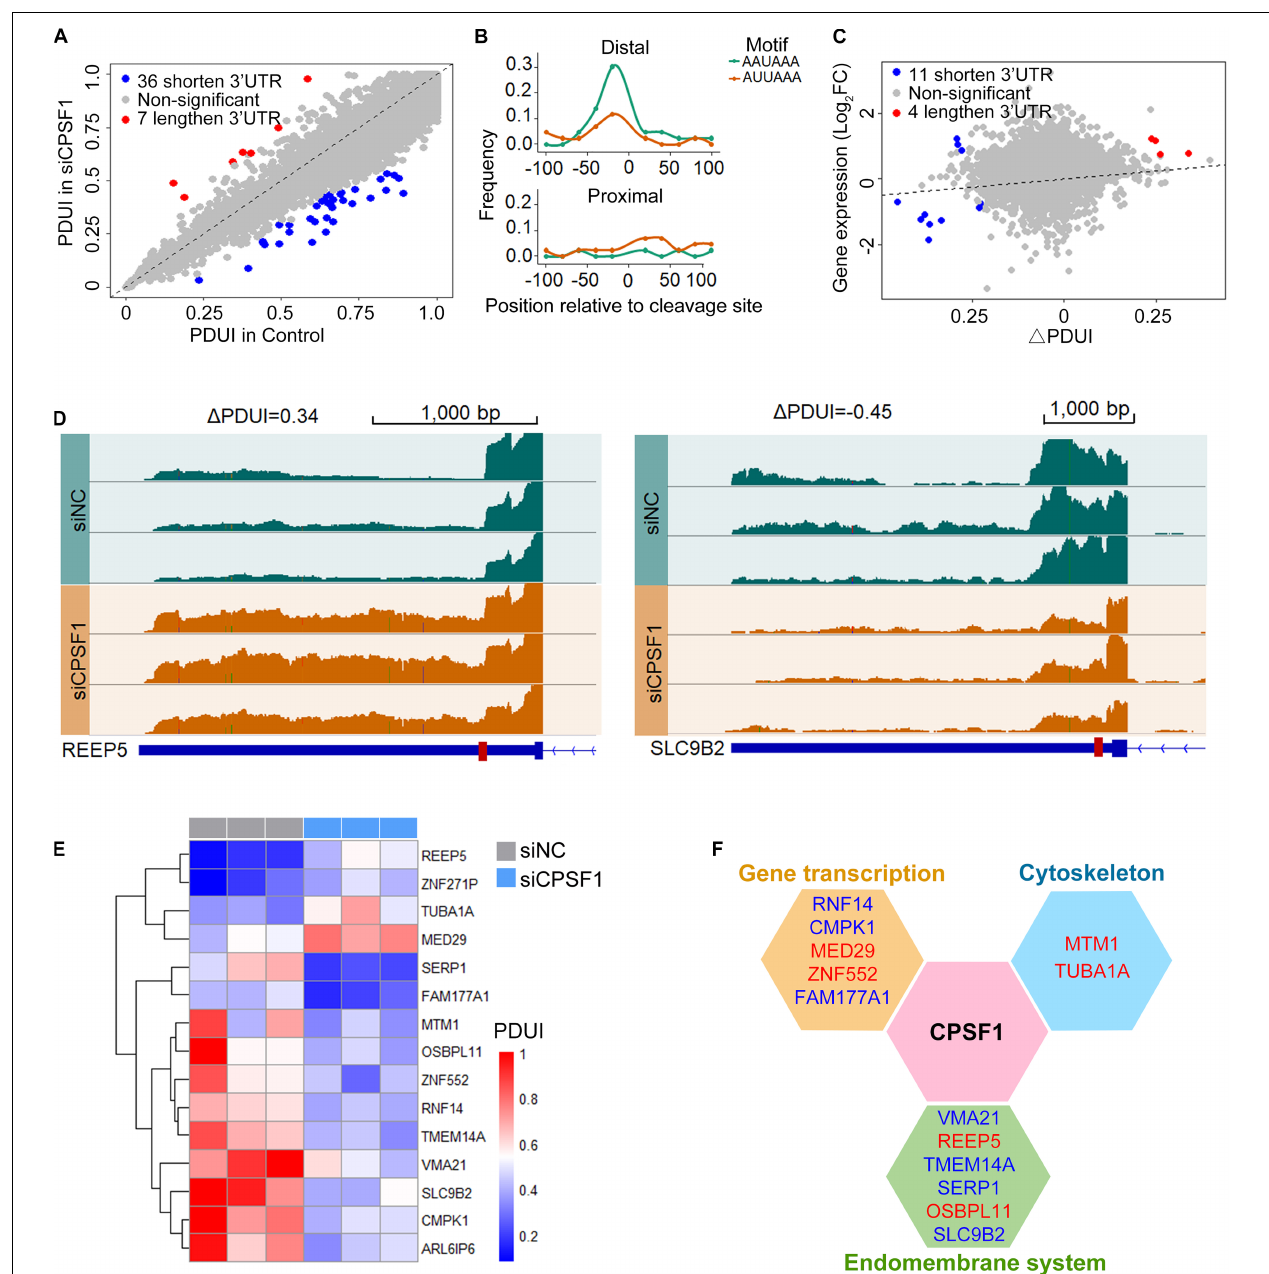
FIGURE 6 | CPSF1 promotes alternative polyadenylation in the 3 (cid:48) UTR. (A) Scatterplot showing the percentage of distal polyA site usage index (PDUI) in the control and CPSF1-silenced groups identified by DaPars. Lengthened and shortened transcripts are highlighted with red and blue dots, respectively. (B) In the filtered transcripts (differential transcripts), the AAUAAA and AUUAAA polyadenylation signals were highly enriched upstream of the distal compared to the proximal polyadenylation sites following CPSF1 silencing. (C) Correlation between PDUI value and gene expression of control and CPSF1-silenced groups. (D) Genome browser plots showing the RNA-seq read coverage in representative genes regulated by CPSF1 with 3 (cid:48) UTR lengthening (REEP5) or shortening (SLC9B2). Red box on the gene body indicates proximal polyadenylation sites predicted by DaPars. (E) Heatmap of PDUI showed the clustering of transcripts with both significantly altered mRNA expression and PDUI. (F) CPSF1-regulated transcripts are significantly associated with gene transcription, the endomembrane system, and cytoskeleton maintenance. Blue indicates downregulated, whereas red represents upregulated